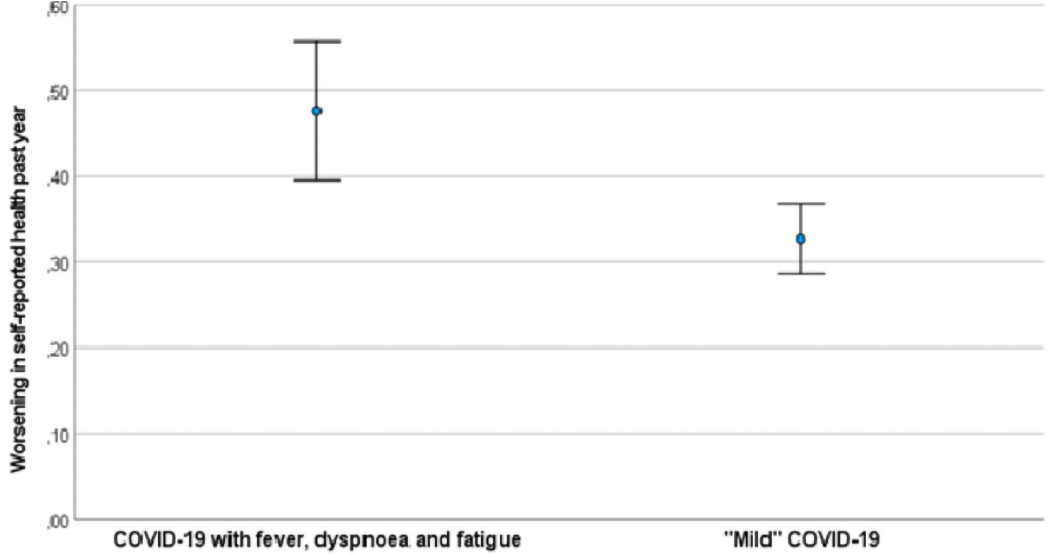
Fig 2. Proportion of participants reporting a worsening of health past year at 3–8 months after baseline stratified on disease severity. The figure shows the proportion of participants reporting a “somewhat” or “much” worse health than one year ago at the time of follow-up. Questionnaire data on symptoms during disease was used to classify patients into the two severity groups. SARS- CoV-2 positive or negative status was based on RT-PCR at Norwegian accredited laboratories at baseline. Error bars are 95% confidence intervals for the means.